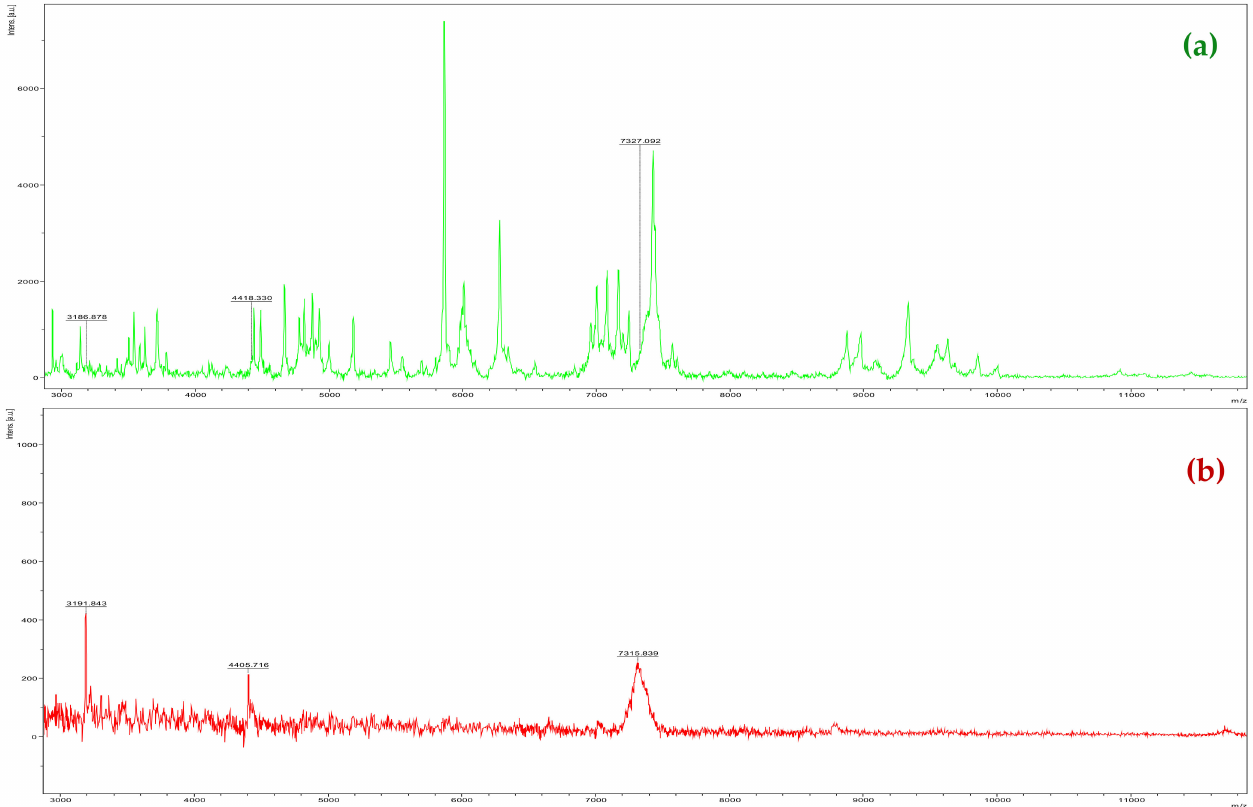
Figure 5. MALDI-TOF MS spectrum of pure culture (PC) of Xcc at 48 h after plating onto NBY agarmedium ( a ) and leaf sample with citrus canker (IT) ( b ). y -axis: ion intensity. x -axis: mass/charge ( m / z